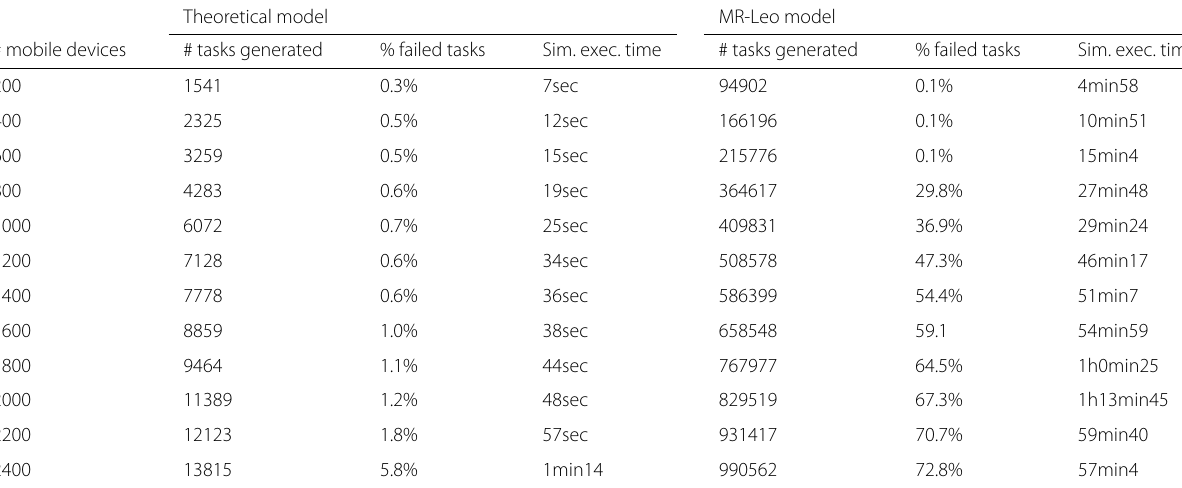
Table 6 Simulation results (only numbers for MR tasks are shown) Theoretical model MR-Leo